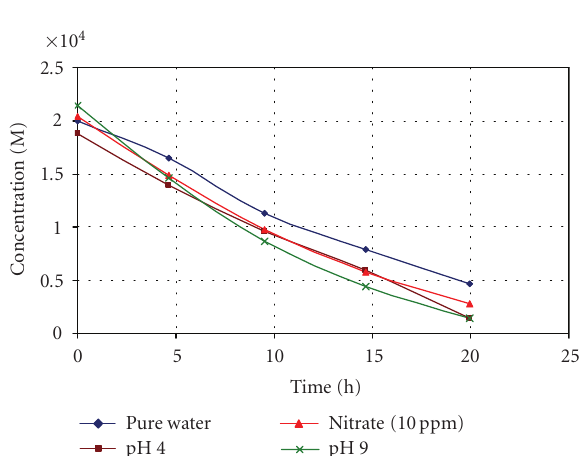
Figure 1: Disappearance of amlodipine-besylate in 10 − 4 M aqueous solution by sunlight exposure under di ff erent conditions.